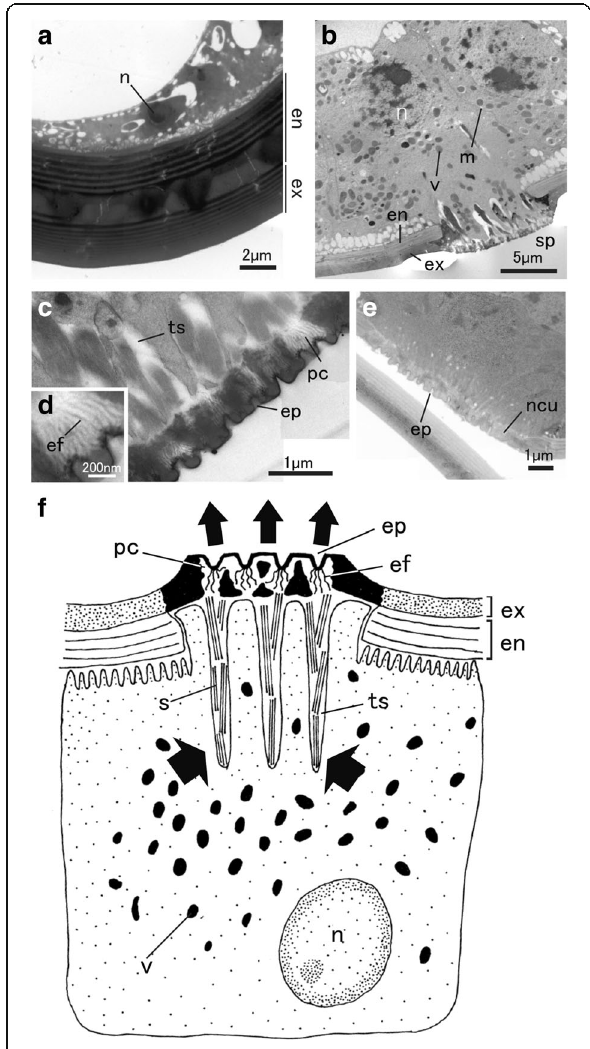
Fig. 4 Ultrastructure of hind tibia epithelial tissues. a : Epidermis and cuticle of a hind tibia from an adult parthenogenetic female. b – d : Epidermis and cuticle of a hind tibia from an adult oviparous female ( b : epithelial cells under the tibial cuticle, c : magnification (× 5) of a scent plaque, d : further magnification (× 10) of a pore canal). e : Hind tibia of a fourth-instar oviparous female. f : Diagram of detailed structures in a scent plaque of an adult oviparous female. Arrows in f indicate pheromone secretion. n: nuclei, v: secretory vesicle, m: cell membrane, en: endocuticle, ex: exocuticle, sp: scent plaque, ts: invaginated tubular structure, ep: epicuticular pore, pc: pore canal, ef: epicuticular filament, ncu: new